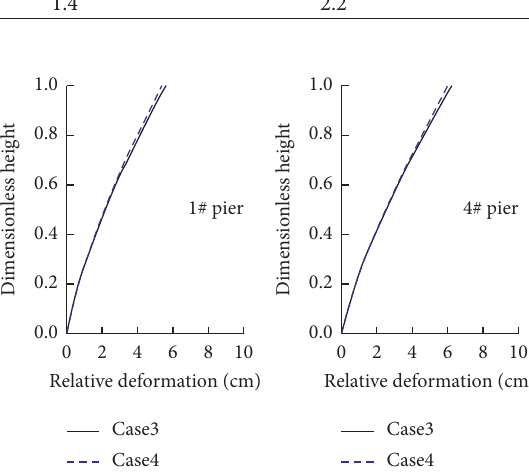
Figure 7: Displacement envelopes of piers in Cases 3 and 4.